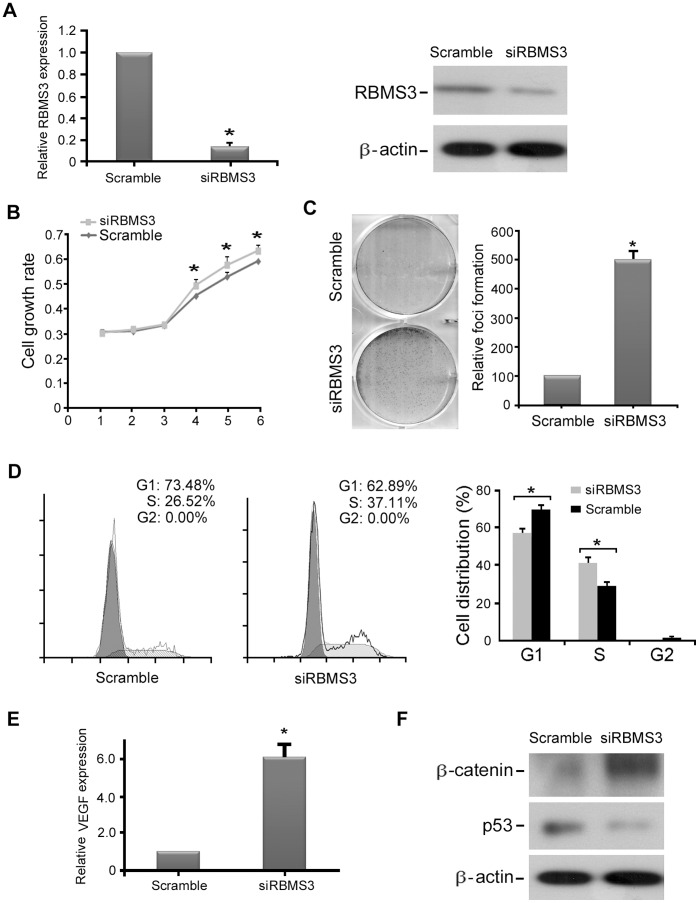

RBMS3-silenced NP460 cell showed malignant features.(A) siRNA against RBMS3 effectively reduced the mRNA and protein expression of RBMS3 in NP460 cells compared to siScramble-transfected cells. (B) An MTT assay was used to compare cell growth rates between siRBMS3- and siScramble-transfected NP460 cells (* p<0.05; ** p<0.001, Student’s t-test). Values were expressed as mean ± SD of three independent experiments. (C) Foci formation assay showed that the number of foci was significantly increased in siRBMS3-transfected NP460 cells compared to control cells (* p<0.05, Student’s t-test). The results were expressed as mean ± SD of three independent experiments. (D) Representative and summary of DNA content detected by flow cytometry showed that the percentage of cells in the S phase was higher while the percentage of cells in the G1 phase was lower in siRBMS3-transfected NP460 cells than that in control cells. (* p<0.05, Student’s t-test). (E) Expression of VEGF in siRBMS3- and siScramble-transfected NP460 cells was confirmed by qPCR. (* p<0.05, Student’s t-test). The results were expressed as mean ± SD of three independent experiments. (F) β-catenin was significantly up-regulated while p53 was significantly down-regulated in siRBMS3-transfected NP460 cells compared to control cells by Western blot analysis. β-actin was used as a loading control.